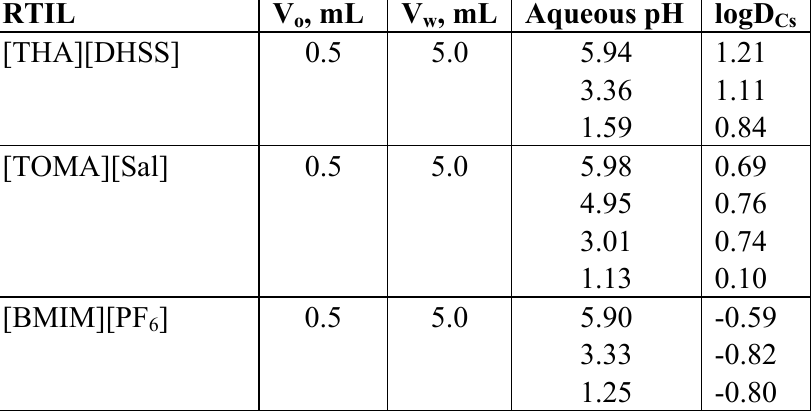
Table 1. Distribution ratios of cesium (C w0 (Cs) = 1.5 × 10 -3 mol·dm -3 ) between RTIL/aqueous phases in the absence of crown ether as a function of pH at 22